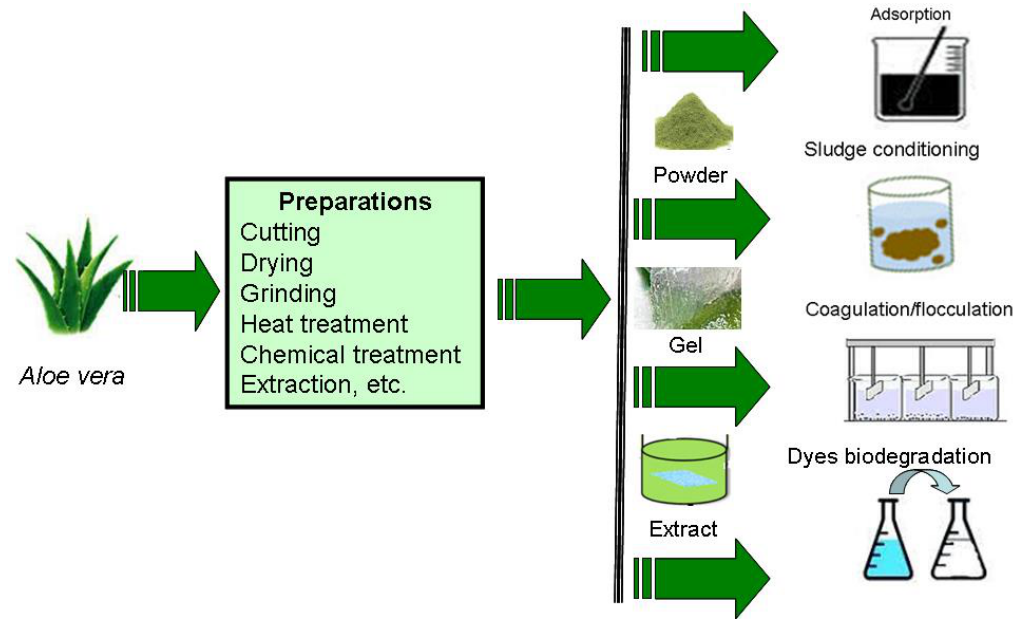
Figure 1. The scheme of Aloe vera preparations and applications for wastewater treatment.